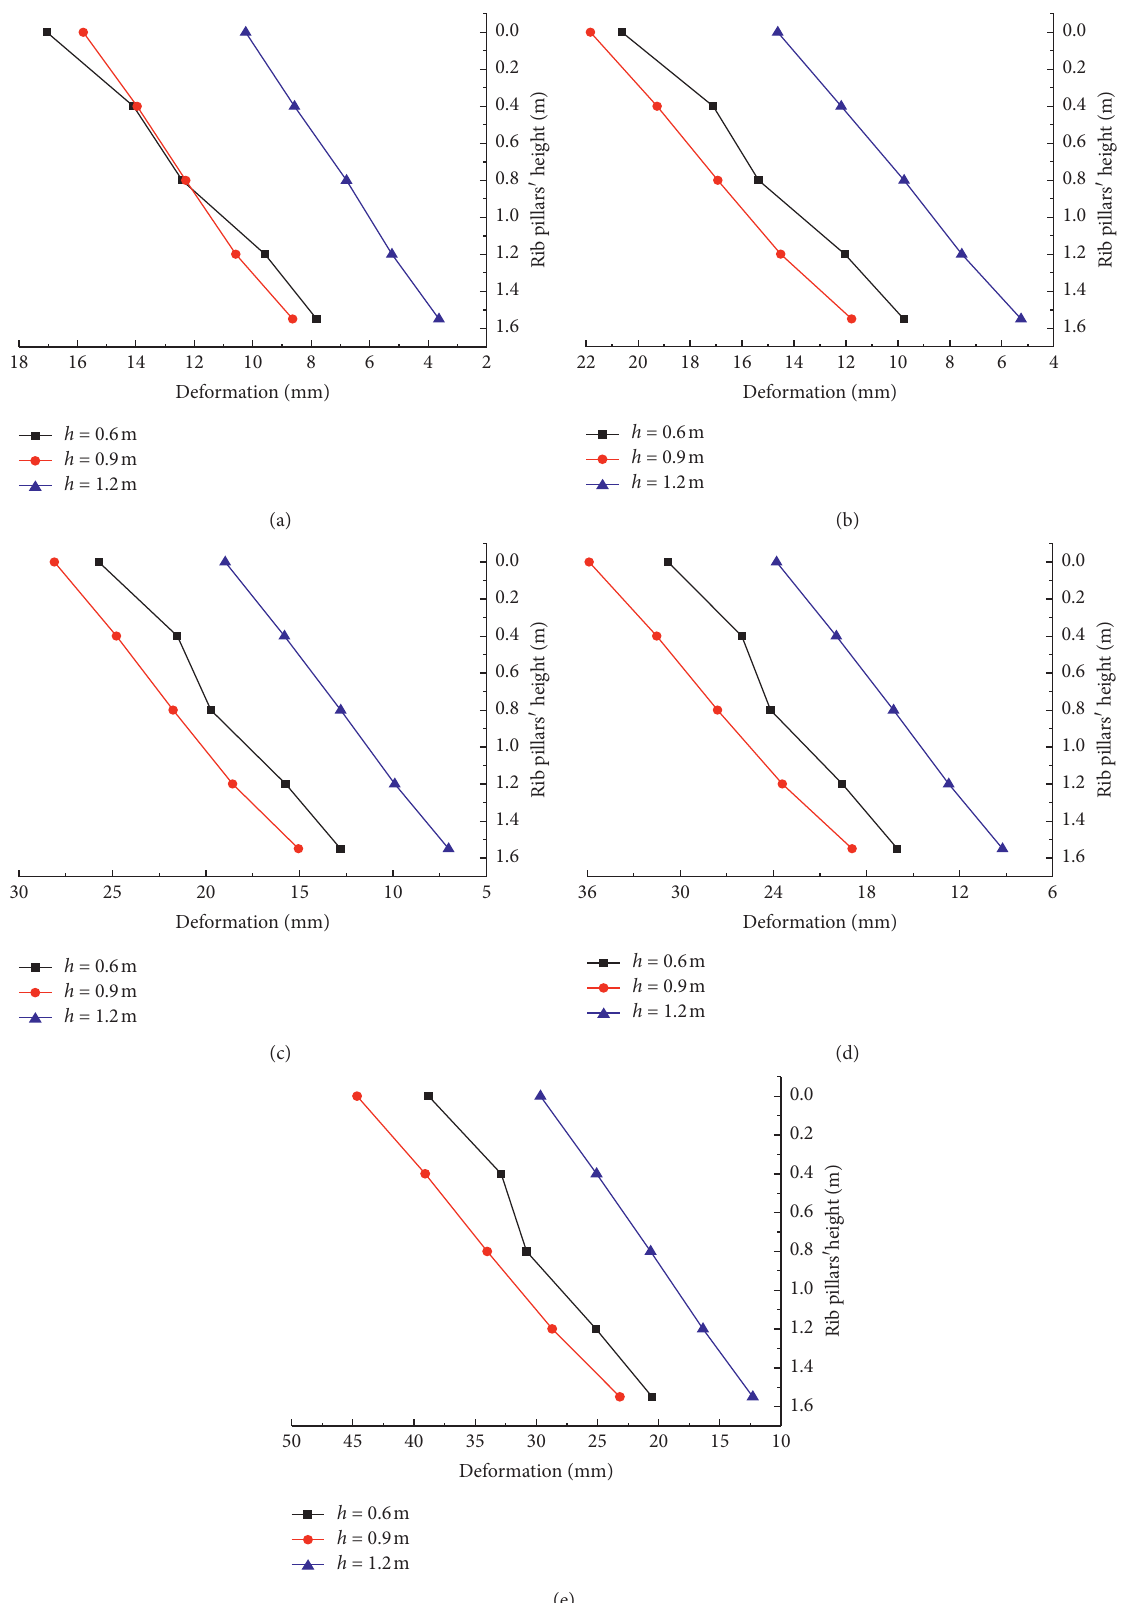
Figure 14: The variation of the deformation of rib pillars with the wall body when B � 0.6m at the external load: (a) B � 0.6m ( p � 10kPa), (b) B � 0.6m ( p � 20kPa), (c) B � 0.6m ( p � 30kPa), (d) B � 0.6m ( p � 40kPa), and (e) B � 0.6 m ( p �